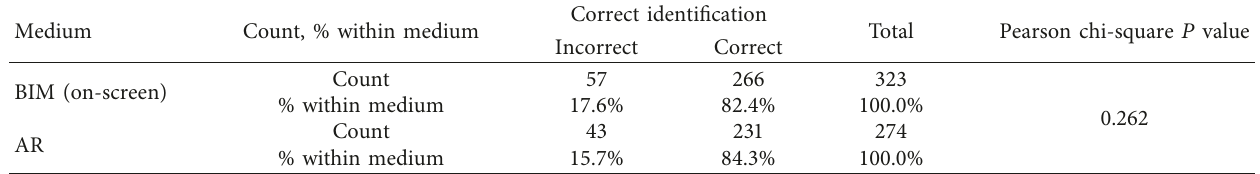
Table 6: Effect of visualization medium on identifying accessibility and corresponding chi-square results.